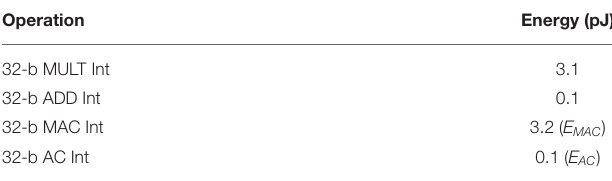
TABLE 1 | Energy table for 45 nm CMOS process. TABLE 2 | Accuracy and Total # parameters for ANN and corresponding converted SNN topologies (refer Table 3 ) for different latency T on CIFAR10 data.